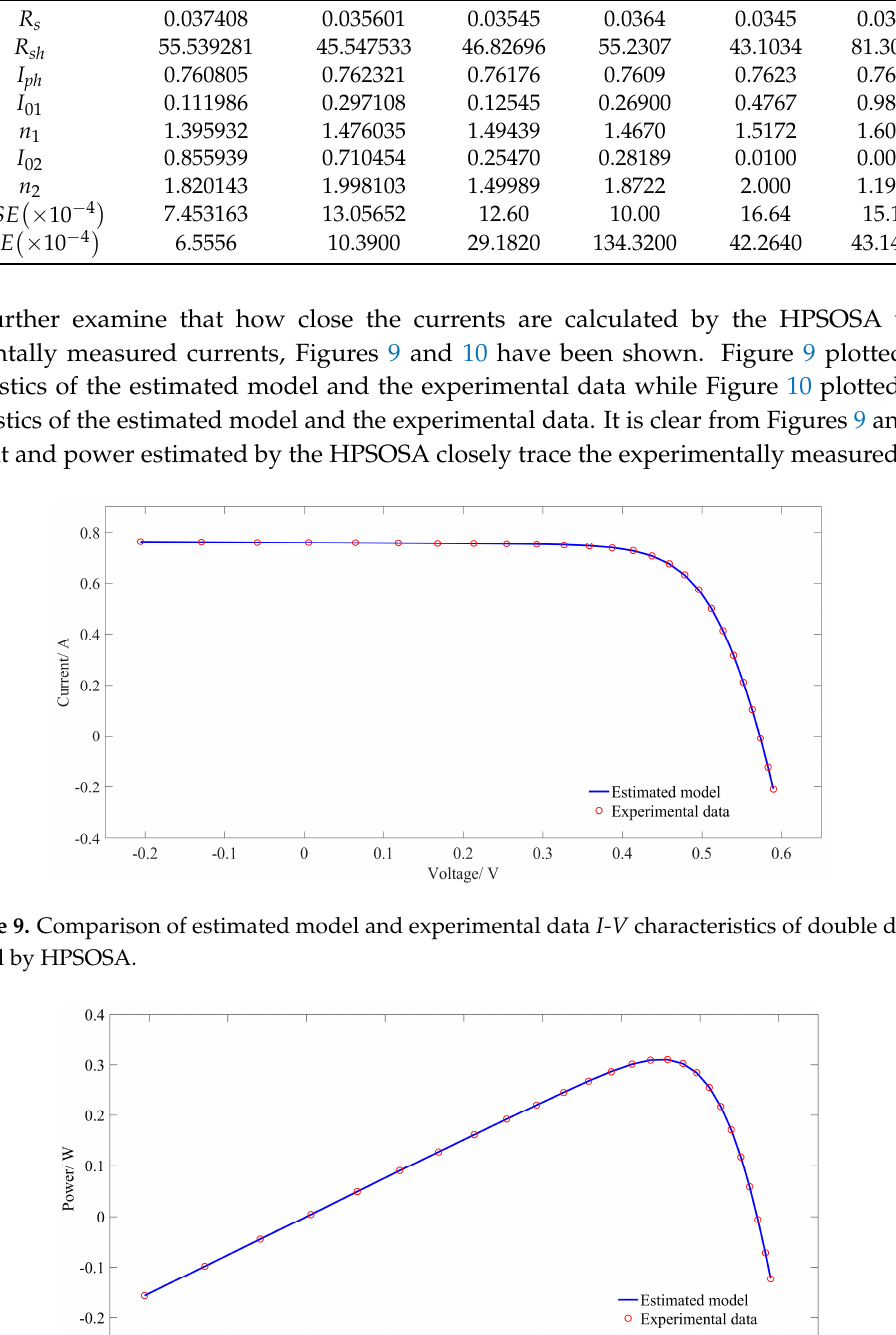
Table 7. Relative error respective to each measurement for single diode PV model. No.